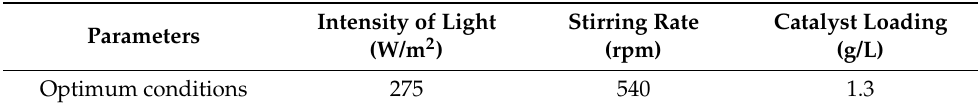
Table 6. Optimized reaction condition generated by DOE software.